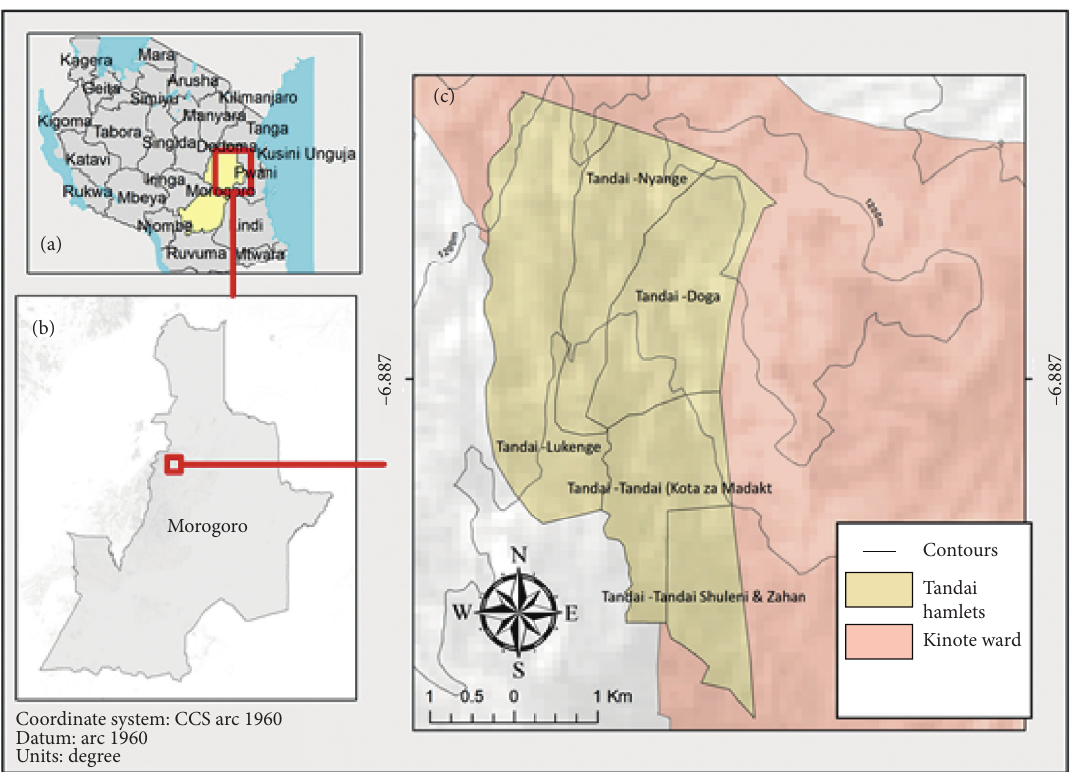
Figure 1: Study area. (a) Tanzania. (b) Morogoro district. (c) Hamlets surveyed in Tandai village of Kinole ward in Morogoro